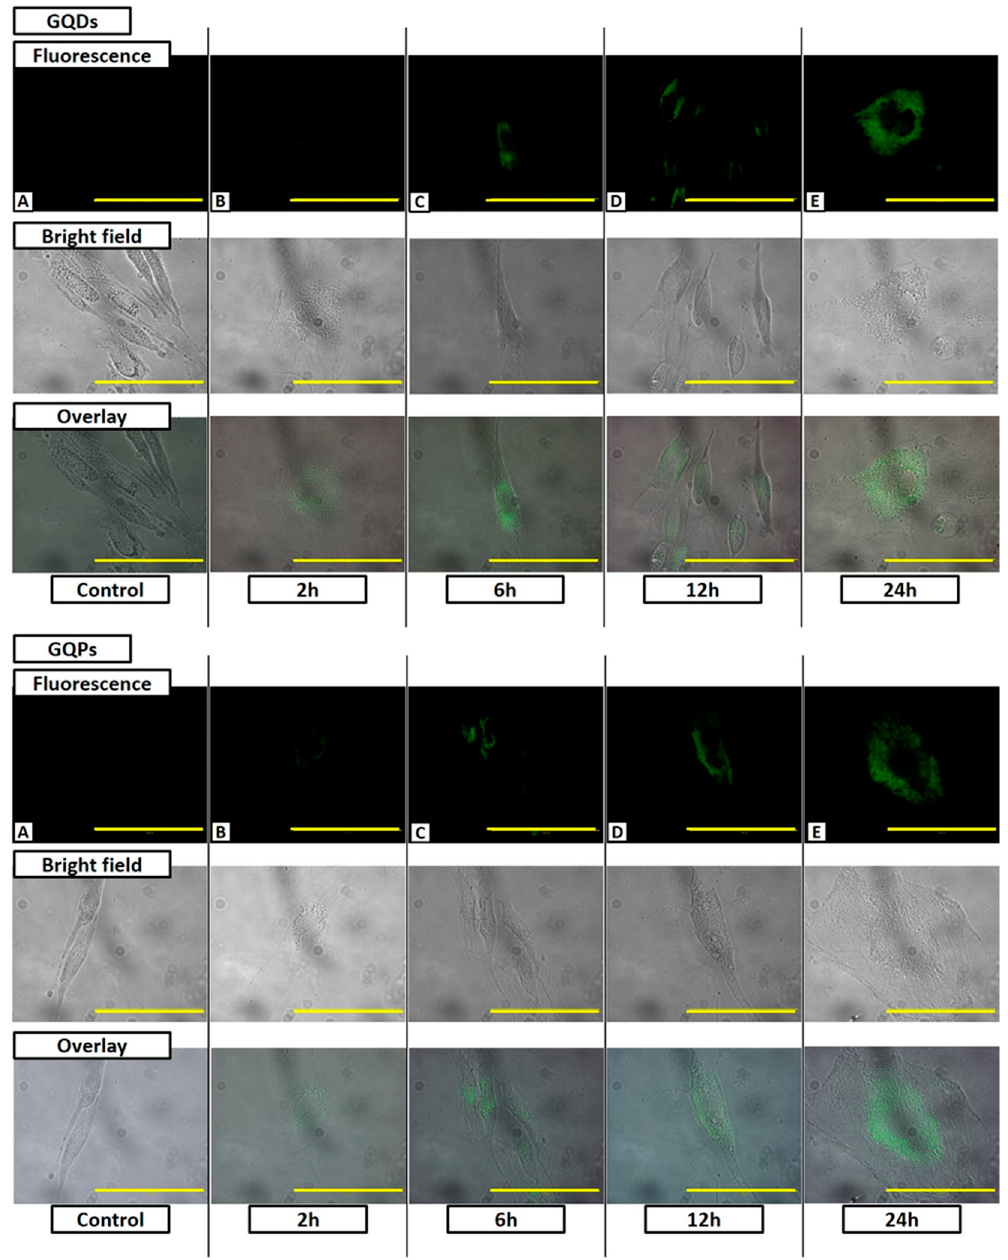
Figure 9. Bio-imaging of GQDs and GQPs in NHDF. Fluorescence emission of both GQDs increased with increasing incubation time. Each scale bar (yellow bar) was 100 μ m.